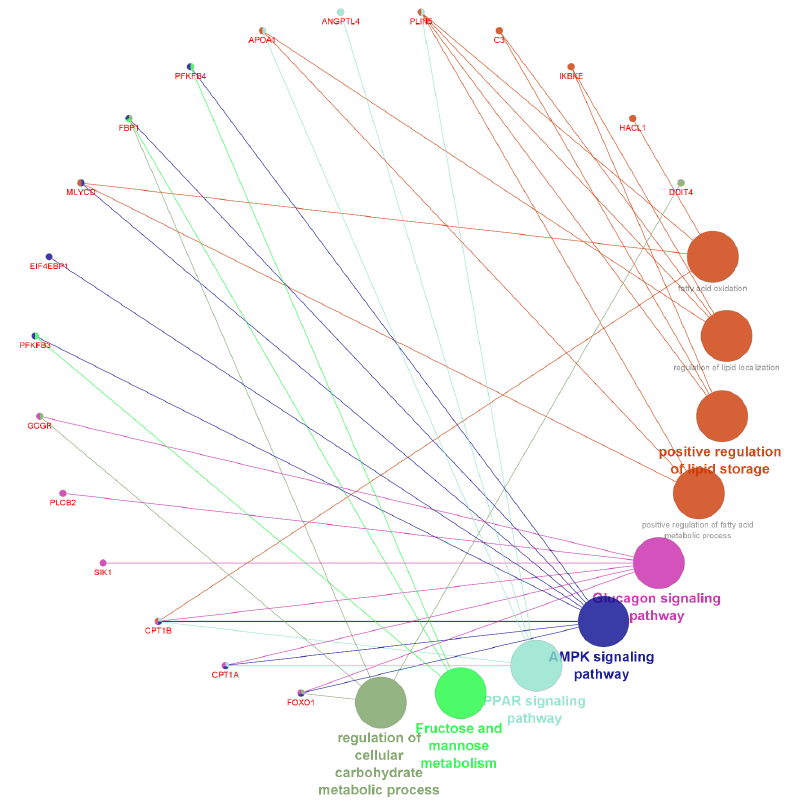
Figure 6. Circular network of shared downregulated DEGs in G2 at weaning between biological processes and KEGG pathways, which were highlighted in ORA and due to their potential relationship with intramuscular fat in cattle.